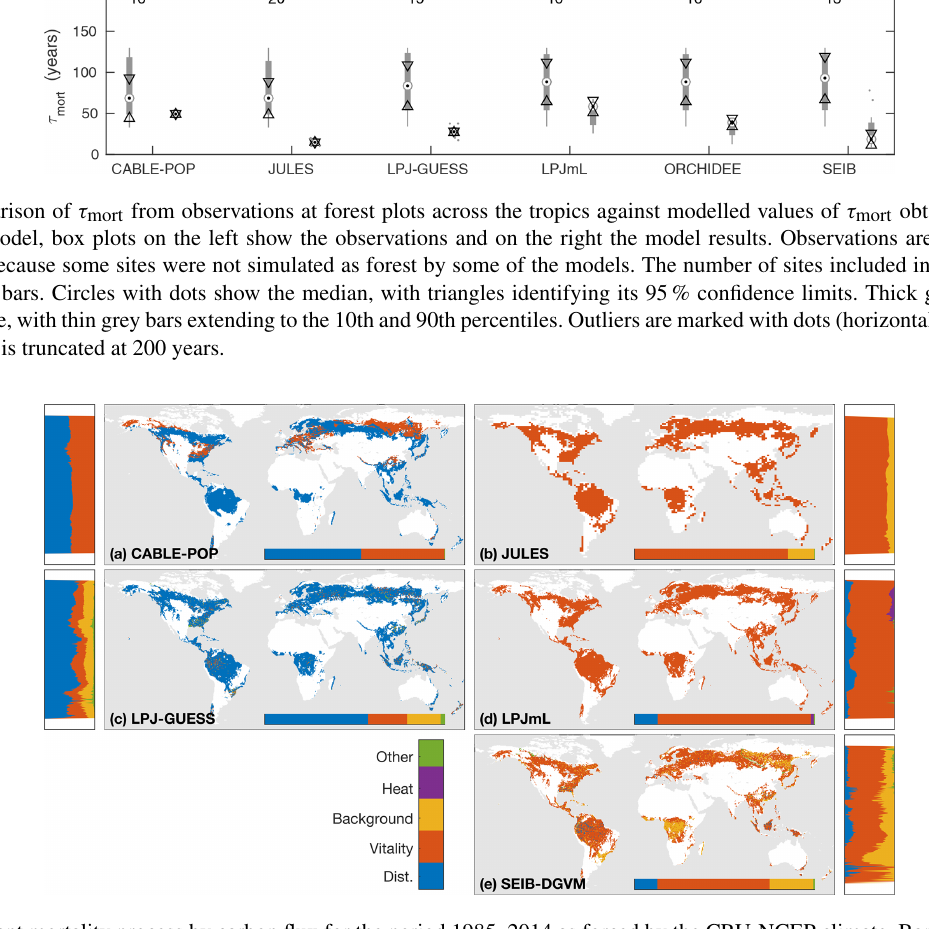
Figure 7. Dominant mortality process by carbon flux for the period 1985–2014 as forced by the CRU-NCEP climate. Bar insets indicate the fraction of the global mortality-driven turnover flux due to each mechanism, whilst vertical side bars show the fraction due to each mortality process across latitude bands. Processes are grouped conceptually following Table 3, and equations and parameters used generally differ between models. “Dist.” is mortality due to forest disturbance and may or may not conceptually include fire, depending on whether the model has an explicit fire mechanism. “Vitality” groups processes such as growth efficiency, self-thinning and more general competition. “Background” covers mortality based on a fixed rate or tree age. “Heat” is heat stress mortality. “Other” includes all processes that did not conceptually fit into one of the categories (Table 3). A breakdown of processes was not available for